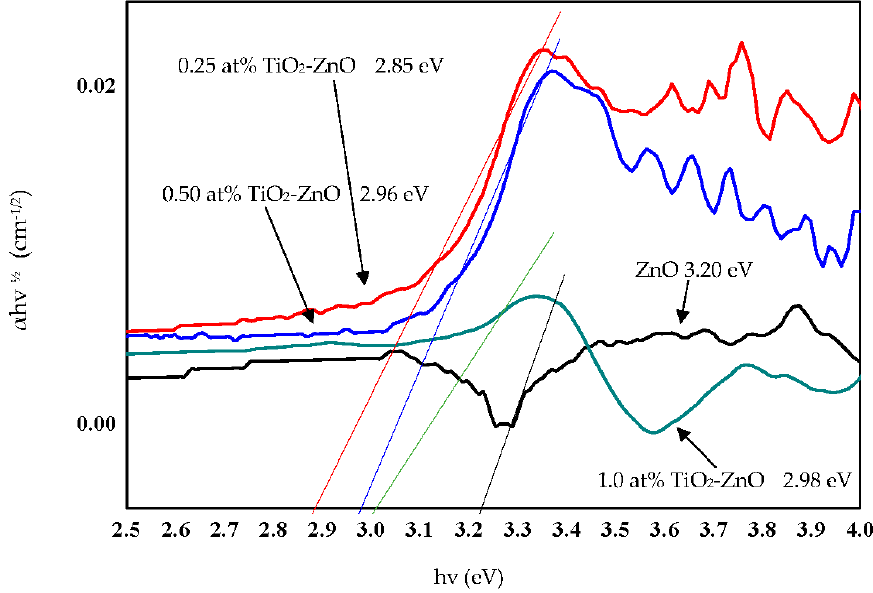
Figure 16. Tauc plot of ZnO, 0.25 at % TiO 2 -ZnO, 0.50 at % TiO 2 -ZnO, and 1.0 at % TiO 2 -ZnO.